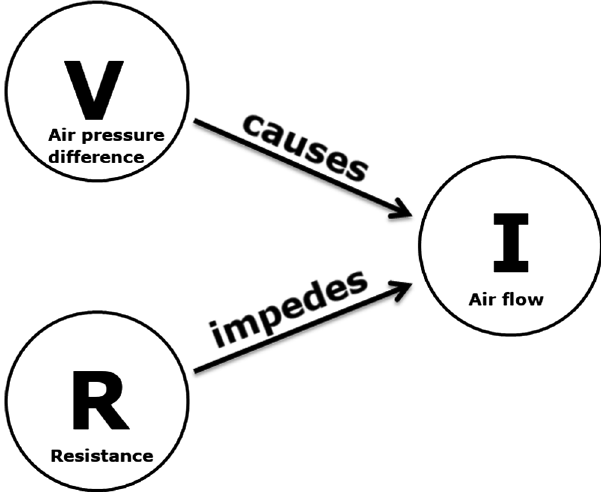
FIG. 3. A sample task to help students distinguish between air pressure and air pressure